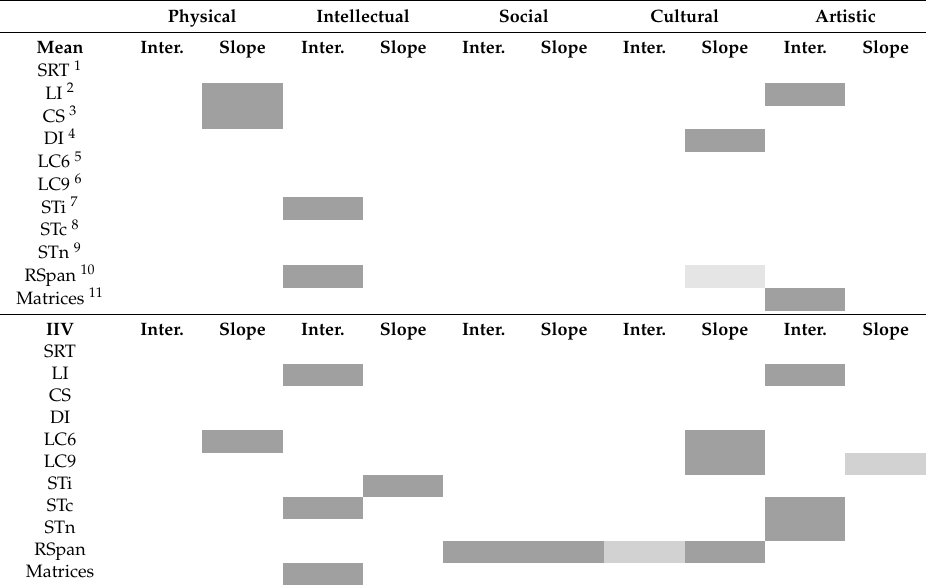
Inter. Slope Inter. Slope Inter.